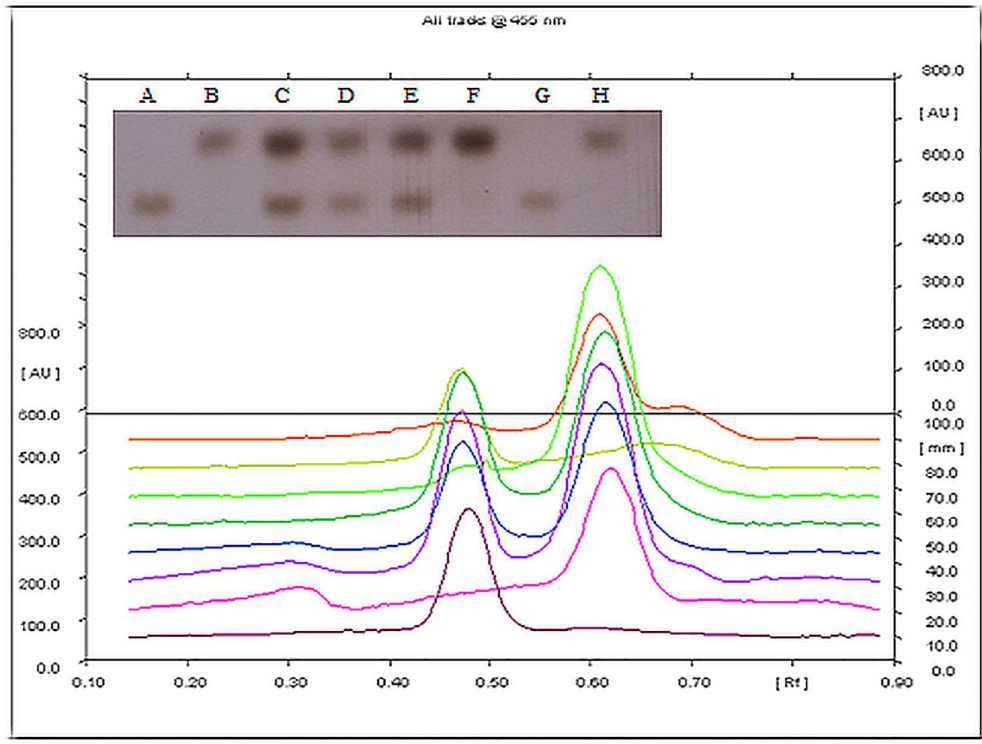
Fig 6. HPTLC Chromatogram (inset) and chromatograph showing the differential sugars i.e. lactulose and mannitol releasedas a markerof intestinal permeability. Inset- A,G–lactulose standard; B,H—mannitol standard; C- Alcohol group showingthe presenceof both the sugars in the serum due to increasedpermeability; D- Alcohol + Encapsulated probiotic-EGCG group showingonly mannitol, no disruption of gut permeability; E- Alcohol fed; F- Alcohol+ Free probiotic-EGCG group showingonly mannitol,confirmingintact gut